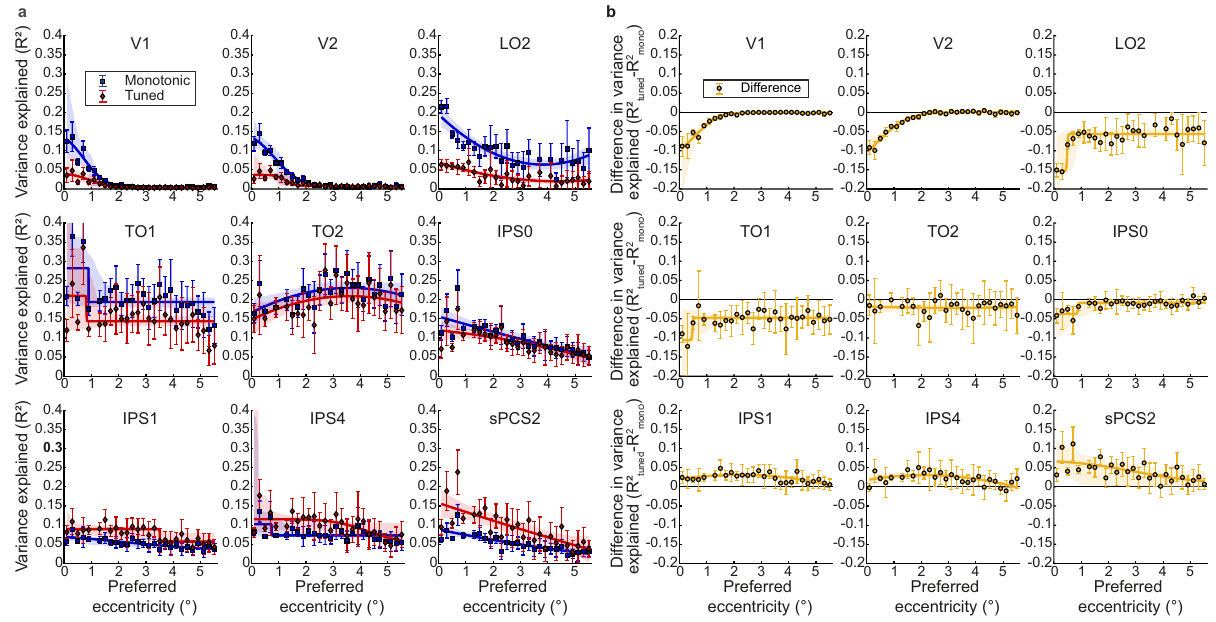
Fig. 5 Progression of timing response model fi ts with preferred visual fi eld eccentricity in a representative selection of visual fi eld maps. a Early and lateral occipital visual fi eld maps show a sharp decrease of model fi ts moving away from the retinotopic representation of the stimulus position. This decrease then becomes more gradual where tuned response model fi ts begin to improve. b The difference between the response model fi ts (tuned - monotonic) also decreases with eccentricity in the early and lateral occipital visual fi eld maps, but shows no consistent relationship with eccentricity after TO1. Markers show mean variance explained per eccentricity bin, error bars show the standard error of the mean. For all bins, n ≥ 50 included voxels. Solid lines show the best fi t to changes with eccentricity, shaded areas around these lines are their 95% con fi dence intervals. Note that the data for these plots are not thresholded to a variance explained above 0.2, but above 0 for the best fi tting model in the data on which the models were fi t. See also Supplementary Fig. 8. Source data are provided as a Source Data fi